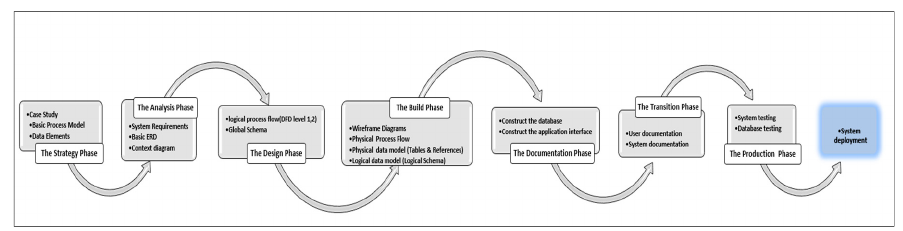
Figure 3. The design lifecycle of the G3DMS using the Barker method.